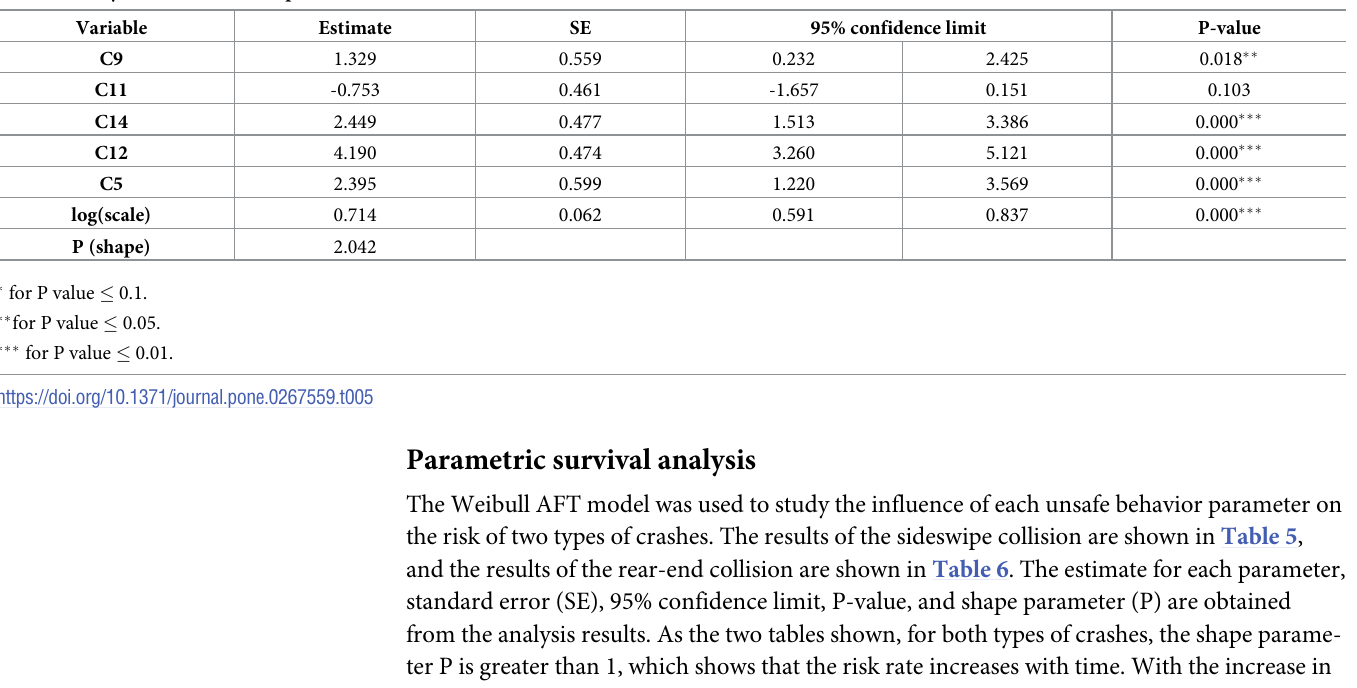
Table 5. Analysis results of sideswipe collision.